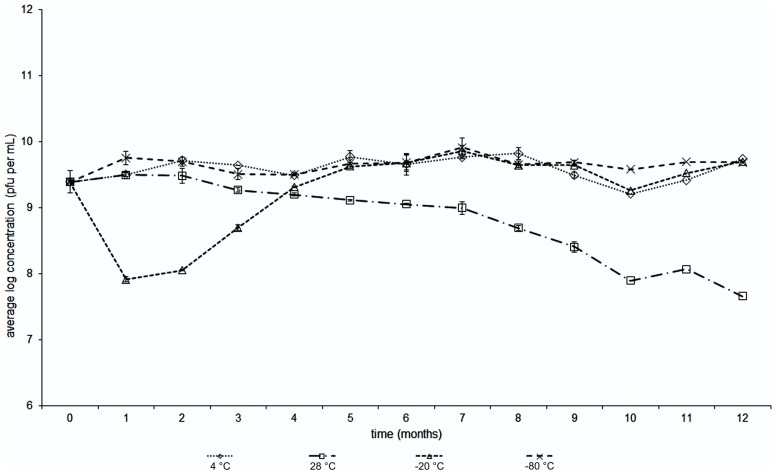
Temperature stability with time of Dickeya spp. bacteriophage BF25/12 incubated at temperatures of +4, +28, –20 and –80°C (as indicated).